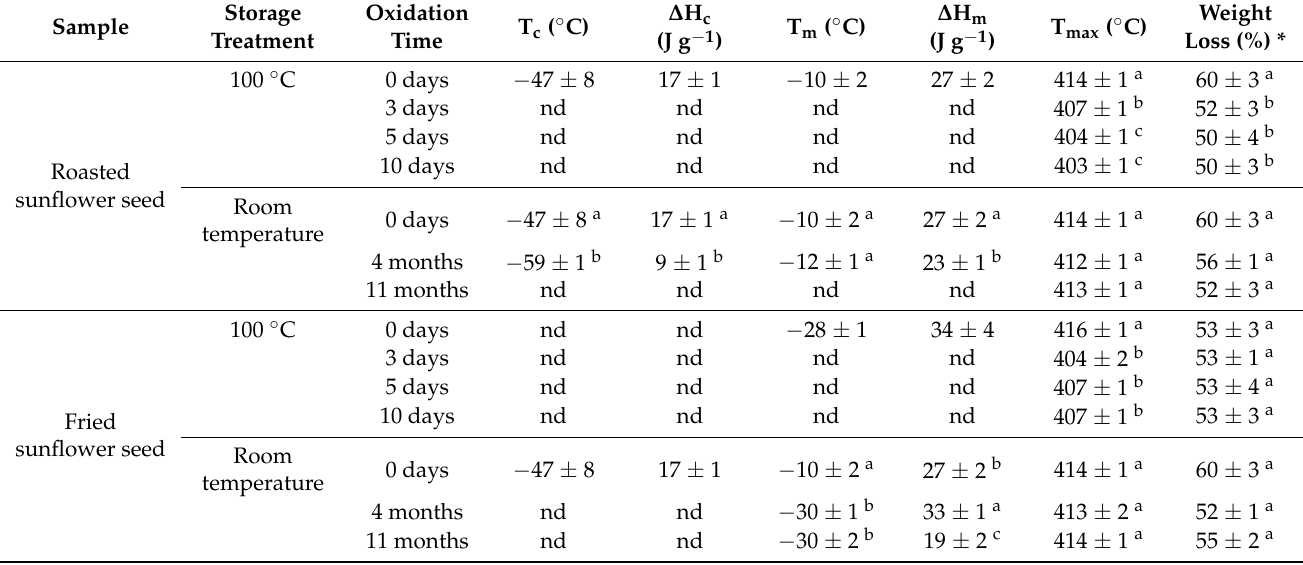
Table 4. DSC and TGA parameters (mean value ( n = 3) ± SD) obtained for sunflower seeds during the oxidative stability study at 100 ◦ C and storage time at room temperature. Different superscripts for each sample within the same column and treatment indicate statistically significant different values ( p < 0.05). nd: non